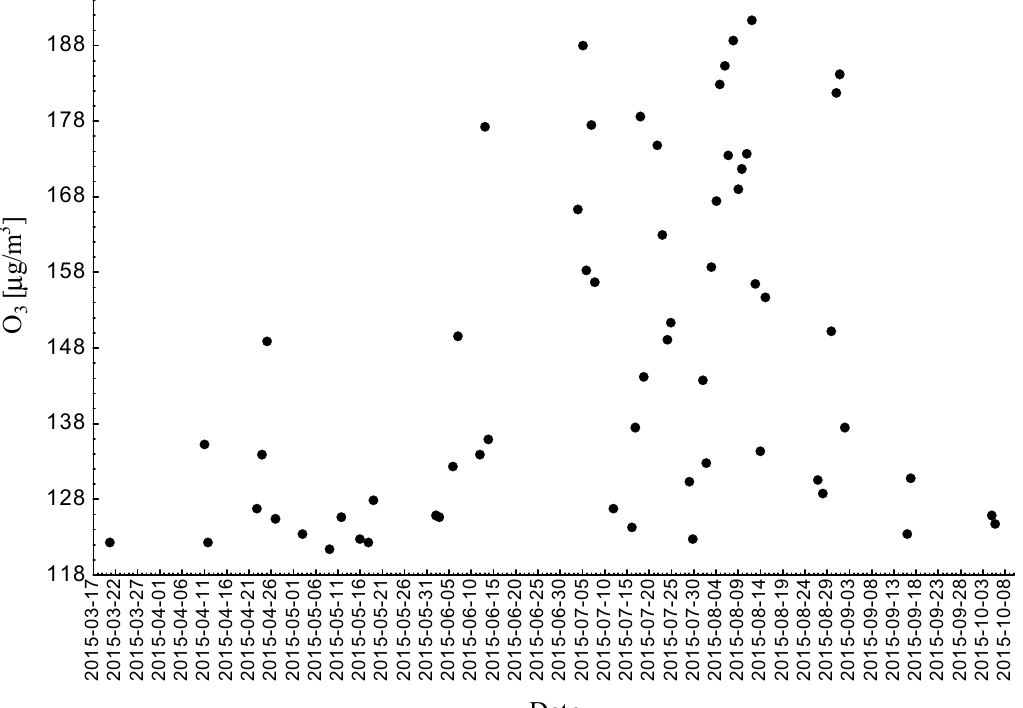
Figure 8. Maximum daily 8-h mean ozone concentration not less (equal to or more than) than 120.4 µg/m 3 registered at the measurement station in Zloty Potok (SL03ZP) in 2015.